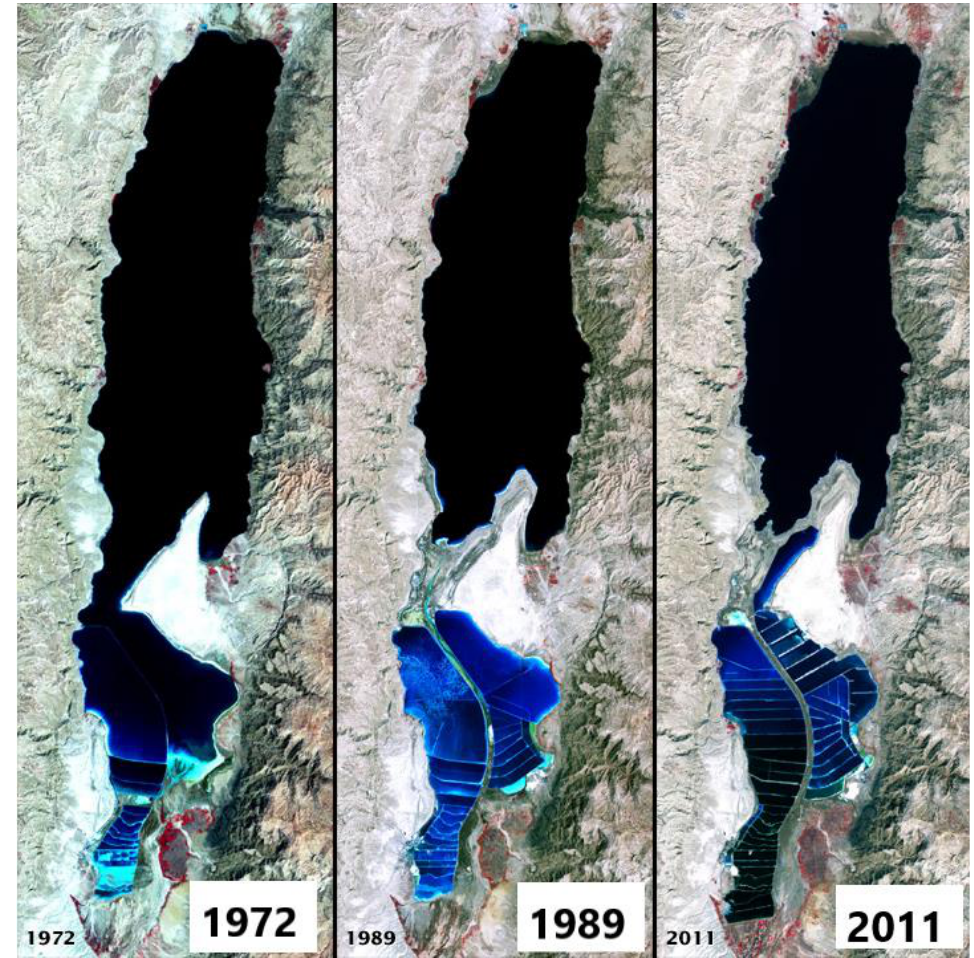
Figure 3. Change in Dead Sea surface area 1972–2011. Source Adapted from (NASA, 2012) https://earthobservatory.nasa.gov/images/77592/the-dead-sea (accessed on 20 April 2021). Note: the distinct color of the southern portion of the basin reflects its transformation from the natural sea to a series of managed evaporation ponds serving mineral extraction industries in Israel and